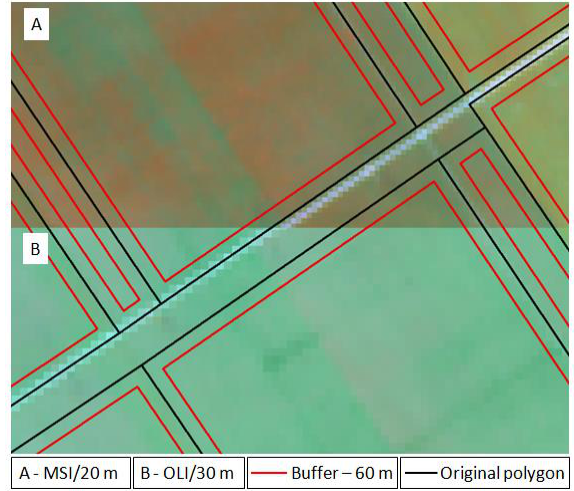
Figure 2. Illustration of crop field boundaries over false-colour compositions of (A) Landsat-8/OLI (R5-G6-B4) and (B) Sentinel-2/MSI (R8A-G11-B4) images. In black are the original polygons and in red the final boundaries considering a buffer zone of 60 m.